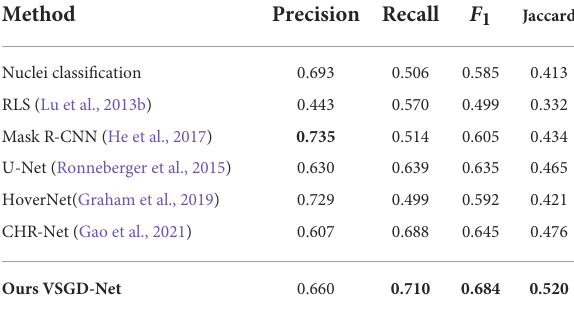
TABLE 1 Comparison with nuclei detection methods for melanocyte detection (This table appears in a manuscript submitted to WACV